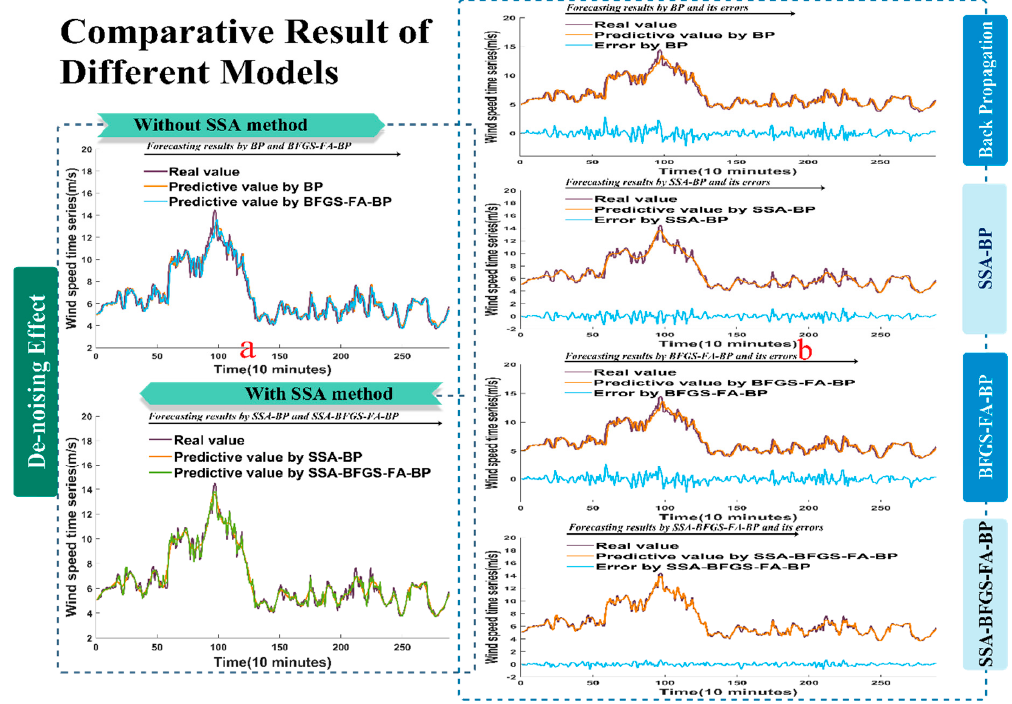
Figure 4. The forecast results for wind speed collected from site 1 at 10-min intervals. ( a ) The forecast effect without SSA algorithm and with SSA algorithm; ( b ) The comparison between the forecast values and raw data and their corresponding errors.